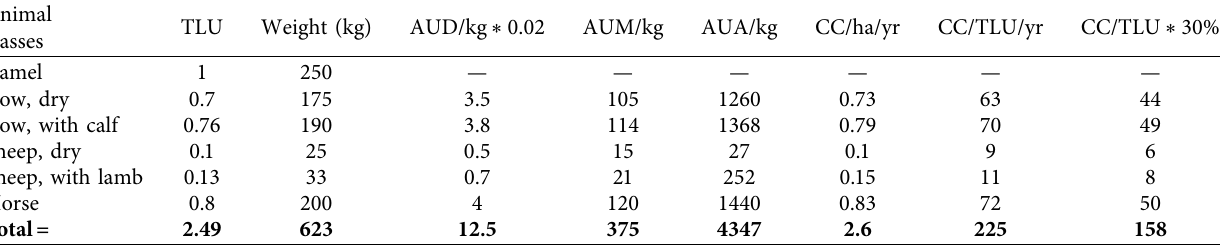
Table 6: An animal class, animal unit equivalent (TLU), the average weight of an animal class, and DM intake per day (AUD), per month (AUM), and per annual (AUA) of an animal class.